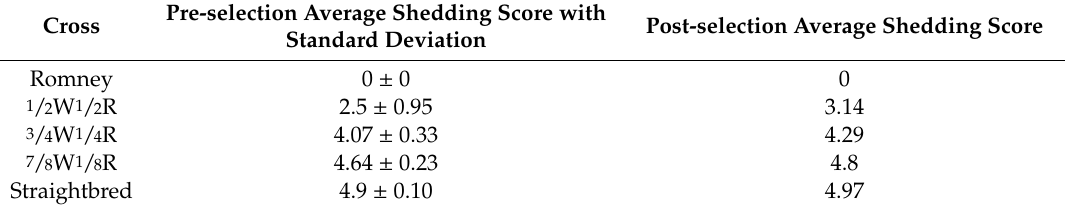
Table 4. Predicted average shedding scores of sheep of varying crosses (e.g., 1 / 2 W 1 / 2 R is a first cross 1 / 2 Wiltshire 1 / 2 Romney) for a whole flock grading up transition from Romney to